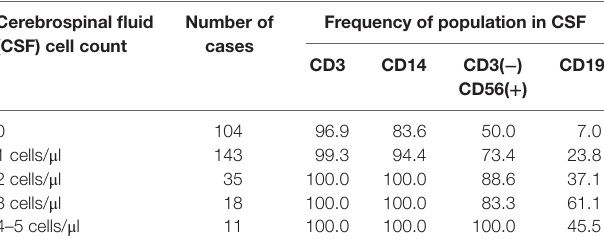
Table 3 | Frequency of population detected by flow cytometry.